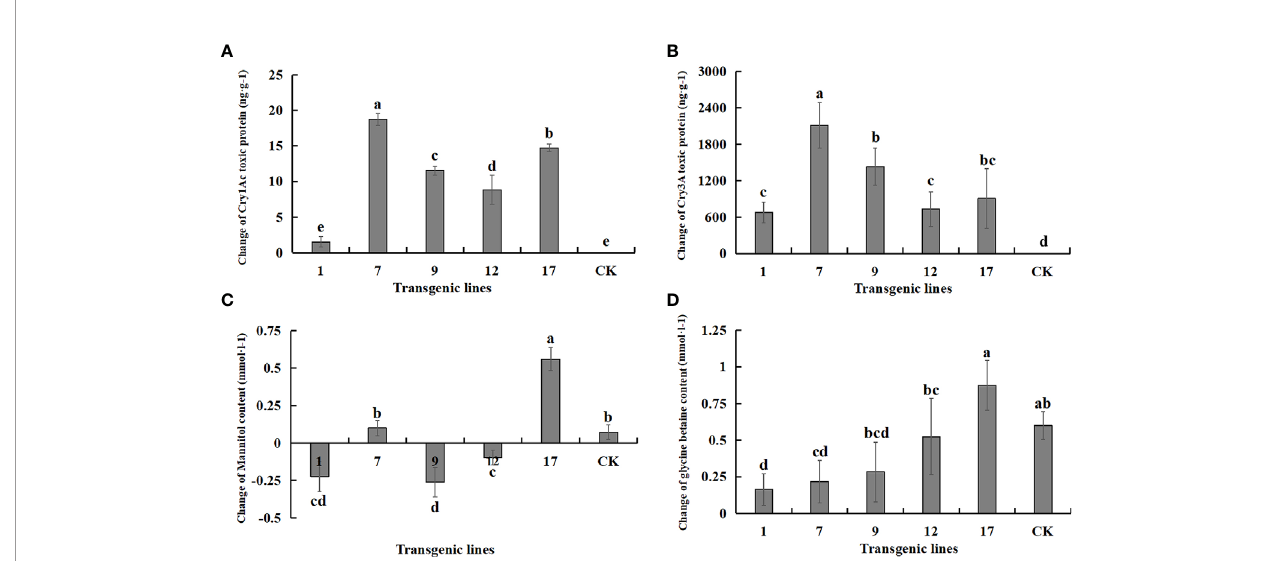
FIGURE 9 | Changes in the content of Insect-resistant gene products and salt-tolerant gene pathway products under salt stress. Insect-resistant gene products: Cry1Ac and Cry3A protein toxins; salt-tolerant gene pathway products: mannitol and glycine betaine. Data are means of three biological replicates of each line, error bars represent the standard deviation of the mean, which is obtained by subtracting the content of each substance in water treatment from the content of each substance in 3 ‰ NaCl concentration. According to Duncan ’ s multiple range test ( p < 0.05), different letters indicate signi fi cant differences and the same letters indicate no signi fi cant differences between the lines. (A) Changes of Cry1Ac protein toxin content. (B) Changes of Cry3A protein toxin content. (C) Changes of mannitol content. (D) Changes of glycine betaine content.